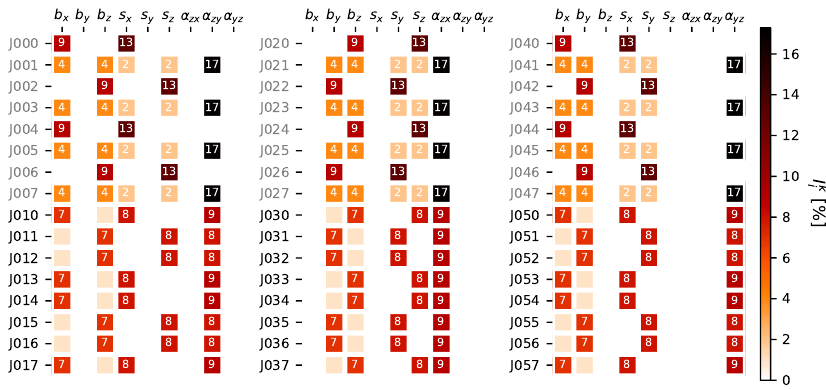
∗ 100 of the positions in L c on the resulting parameter variances of the Figure 6. Improvement terms I k i initial 24 position scheme (positions already contained in L 0 are written in